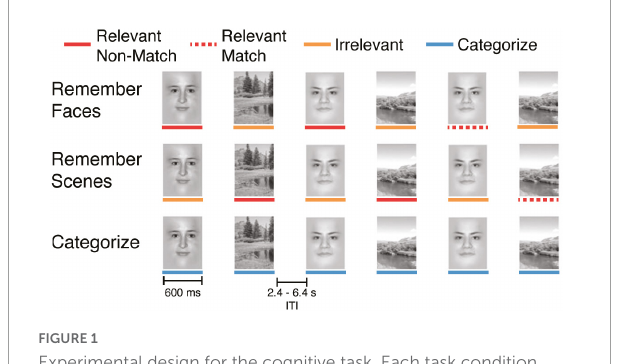
FIGURE1 Experimental design for the cognitive task. Each task condition consisted of 20 sequentially presented stimuli (10 faces and 10 scenes). Colored lines under the stimuli are presented for illustrative purposes and were not present during the task.